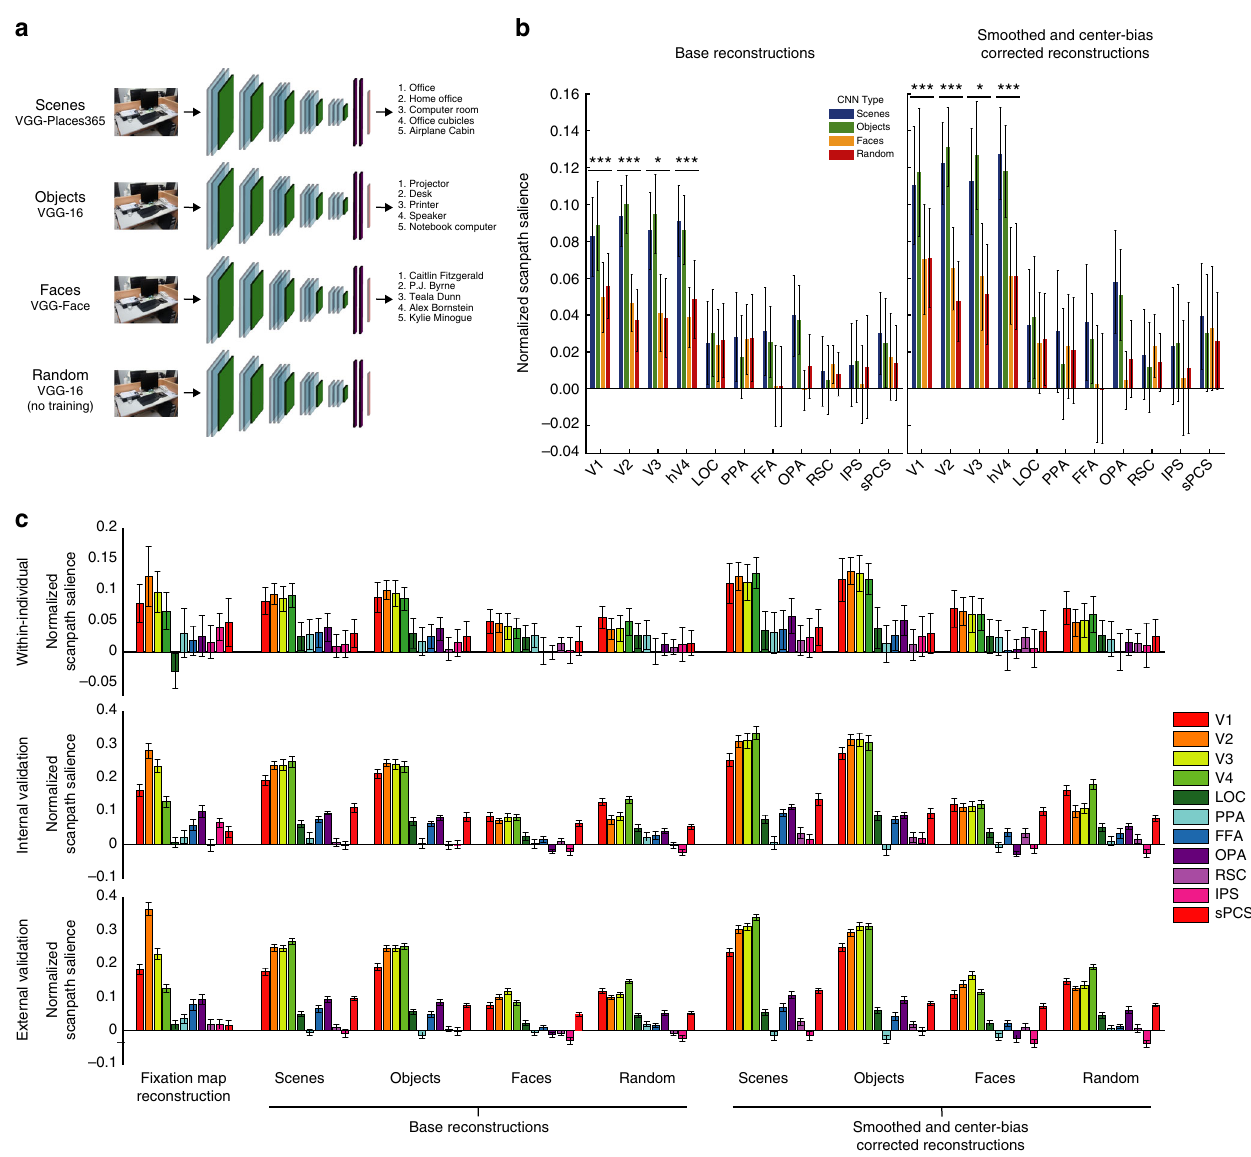
Fig. 7 Eye movement prediction performance depends on the training regime for the CNN to which fMRI activity is aligned. a To assess the features that support guidance of eye movements in the brain, we used CNNs with identical VGG-16 architectures pre-trained for different types of visual categorization as the foundation for our model-based decoding pipeline. In addition to the scene-categorization CNN used in our primary analyses (VGG-Places365) 11, 12 , we used a CNN trained for object categorization (VGG-16) 10 , a CNN trained for face identi fi cation (VGG-Face) 21 , and a CNN with no goal-directed training (VGG-16 with random weights). The dimensionality and depth of the units in each CNN are identical, but the different training regimes result in different sets of learned features optimized to support different types of visual recognition. b Within-individual prediction performance from model-based reconstructions according to the type of pre-training the CNN received. Results are shown for the base reconstructions and the smoothed/center-bias corrected reconstructions. We observe a main effect of CNN type in the same regions that provide the best prediction performance. CNNs trained for scene- and object-categorization provided the best prediction performance, suggesting that the same features that support visual categorization of natural stimuli in the brain may generalize to guide spatial attention to natural scenes. * P < 1 × 10 – 2 , ** P < 4.5 × 10 – 3 (Bonferroni-corrected threshold), *** P < 1 × 10 – 3 . c Eye movement prediction performance for all model-based reconstructions in all ROIs. Prediction performance for direct fi xation map reconstructions is included for comparison. Error bars represent standard error of the mean within the current data set ( n = 11, Within-individual and Internal validation) or within the external validation data set ( n = 22, External validation). Signi fi cance for all analyses was assessed using permutation tests. Predictions from V1, V2, V3, and hV4 were signi fi cant for all analyses ( P <